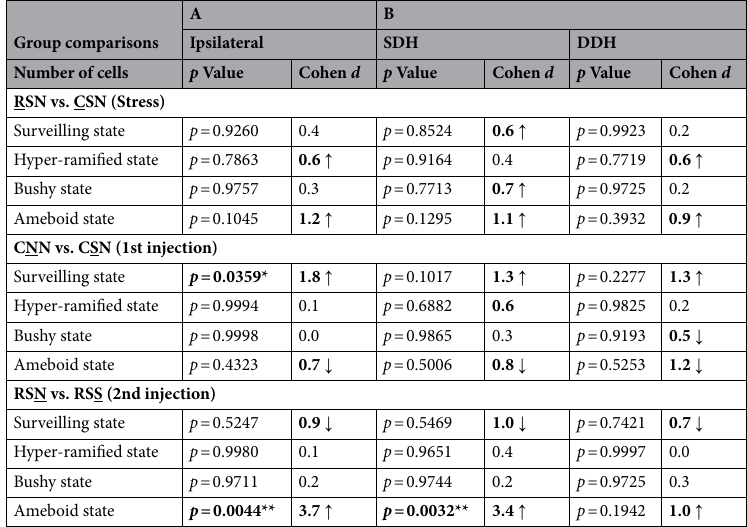
Table 3. Comparison of microglia cell numbers in different states. The table shows the statistics for number of microglia cells in different morphological states ( A ) on the ipsilateral side and ( B ) on the superficial and deep dorsal horn on the ipsilateral side. The number of cells were counted for each ROI and averaged across ROIs within each animal. The statistics were performed using the mean ± SEM. P < 0.05 (two-way ANOVA followed by Tukey post hoc analysis) was considered significant indicated by * and effect size was calculated using Cohen d . The group comparisons shown here are based on the factors: 1) repeated restraint stress (R) and control (C), 2) NGF (N) and saline (S) injections. ROI, region of interest; SDH, superficial dorsal horn; DDH, deep dorsal horn; Iba-1, ionized calcium binding adapter molecule 1; NGF, nerve growth factor. CSN: control + saline + NGF; RSS: repeated restraint stress + saline + saline; CNN: control + NGF + NGF; and RSN: repeated restraint stress + saline + NGF.